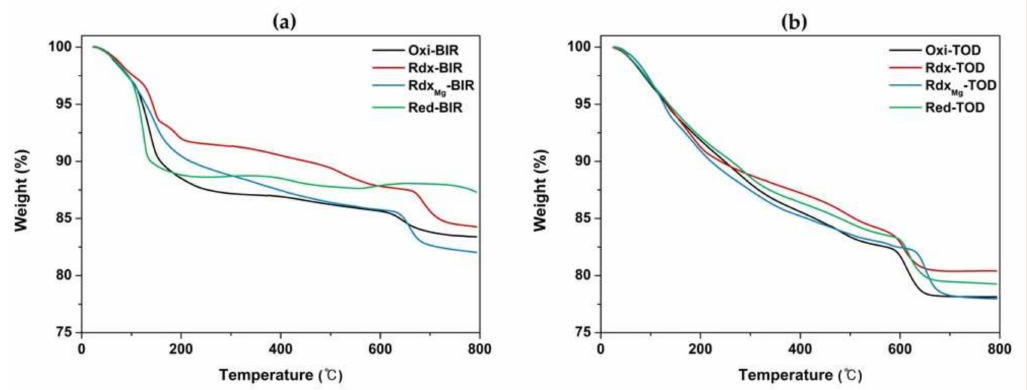
Figure 3. Thermogravimetric analysis (TGA) curve for the synthesized birnessite ( a ) and todorokite ( b